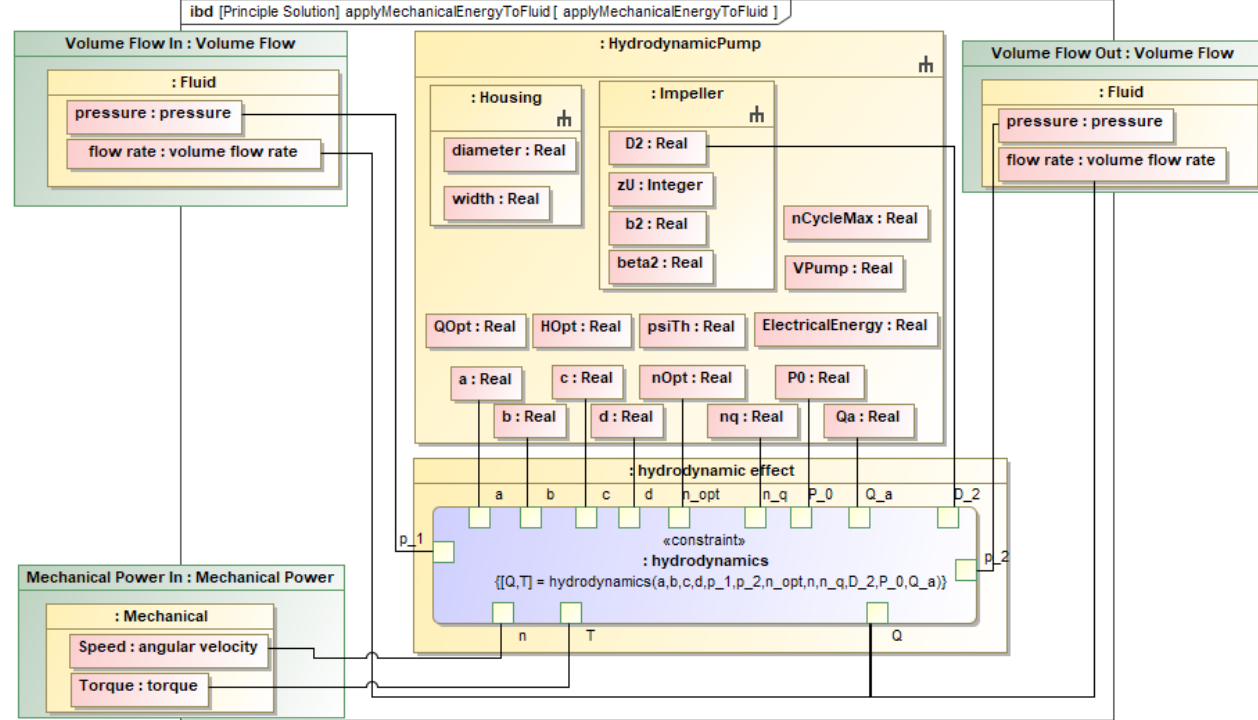
Figure 4. Architecture of the hydrodynamic pump as a principle solution of the function apply mechanical energy to fluid .